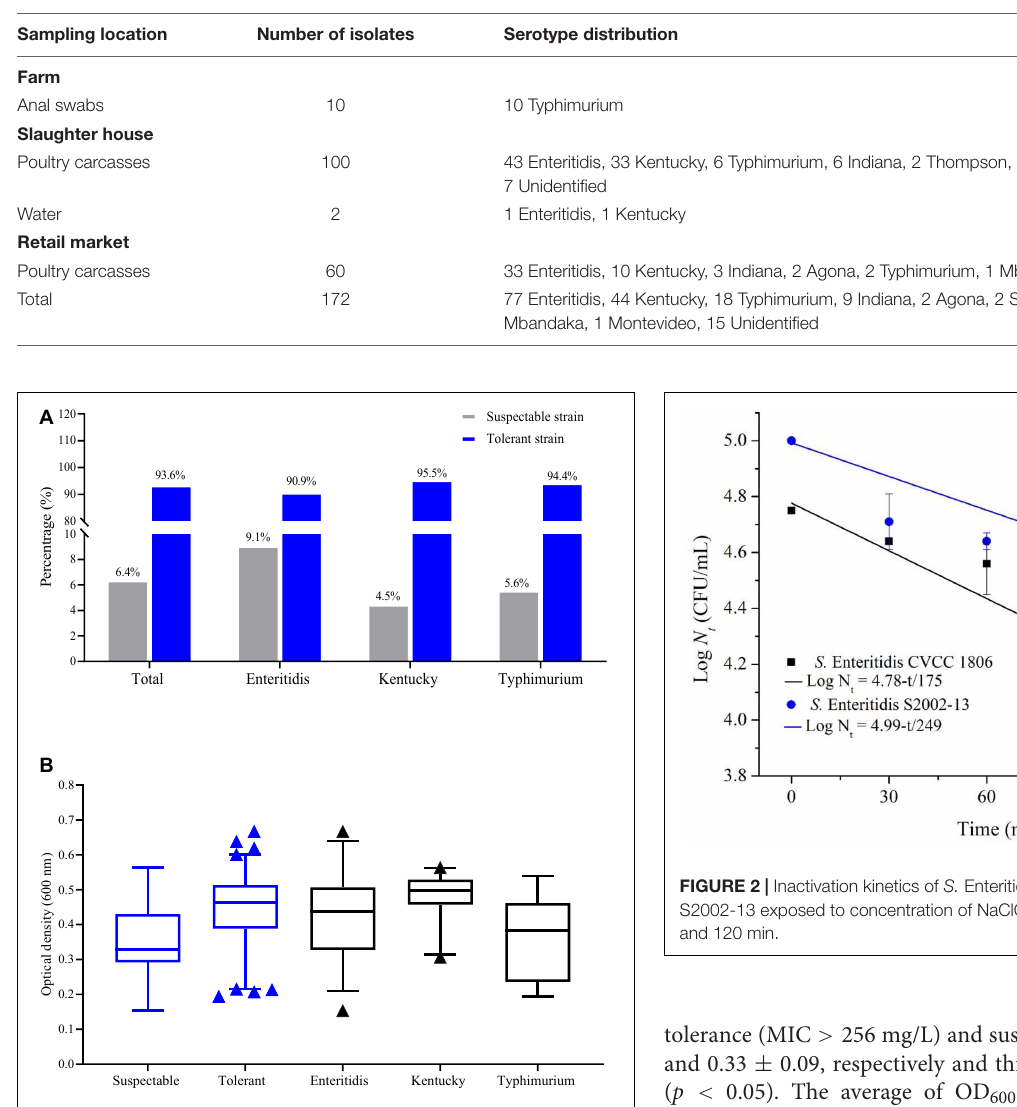
TABLE 2 | Bacterial of Salmonella spp. isolated from poultry supply chains.